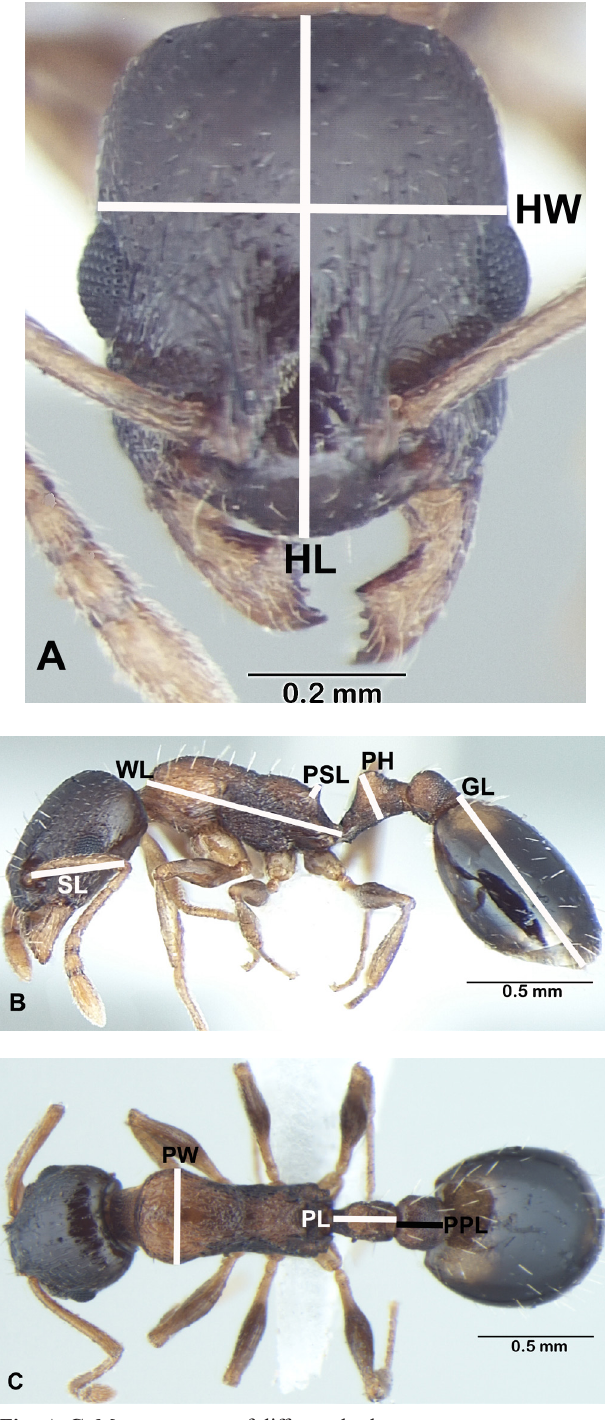
5 prominent teeth; antennae 12 segmented, scape short, barely reaching posterior margin of